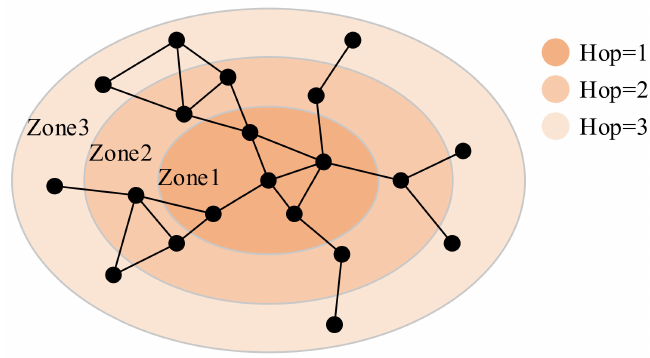
Figure 2. Scope of fisheye.